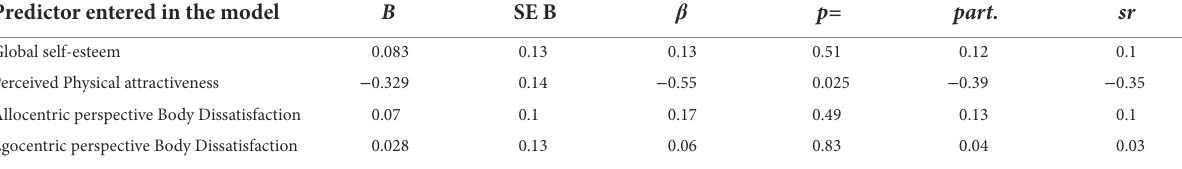
TABLE 4 Summary of multiple regression analyses for variables predicting the Global Qualitative dimensions score of excessive exercise. Predictor entered in the